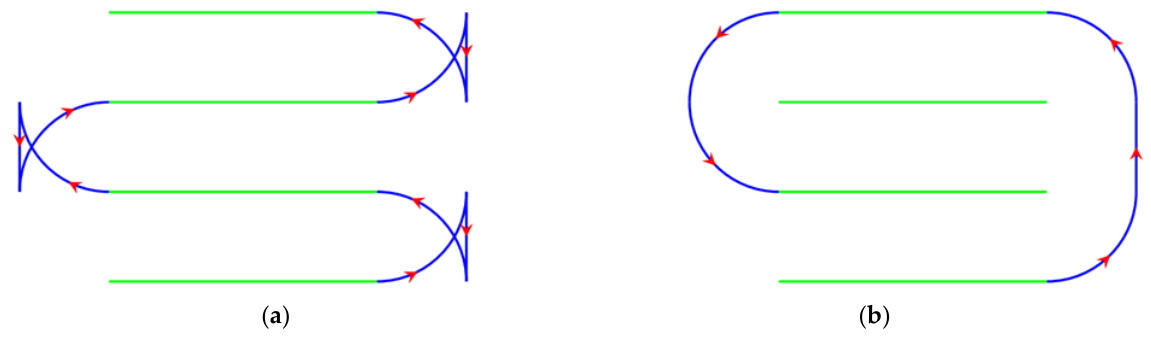
216 217 218 219 220 221